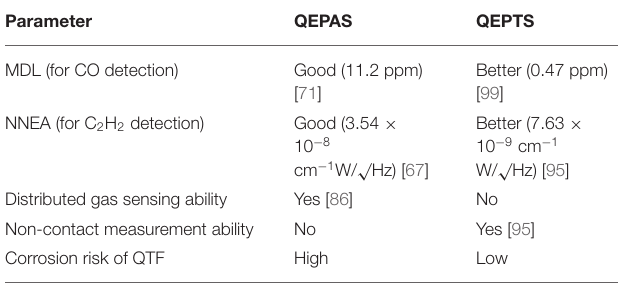
TABLE 2 | Performance comparison between QEPAS and